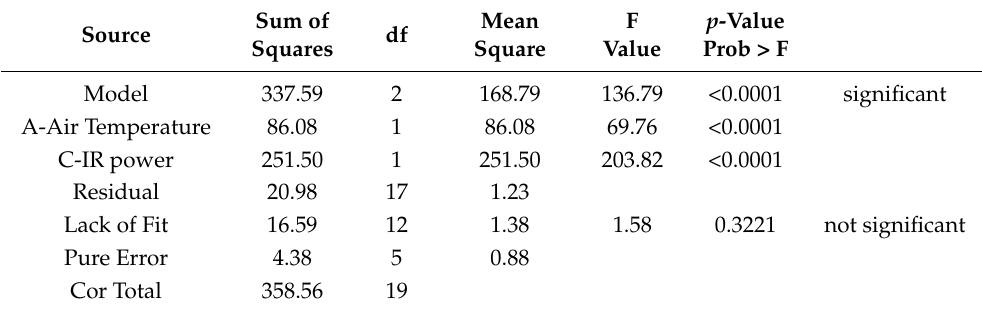
Table 7. Analysis of variance for color response using